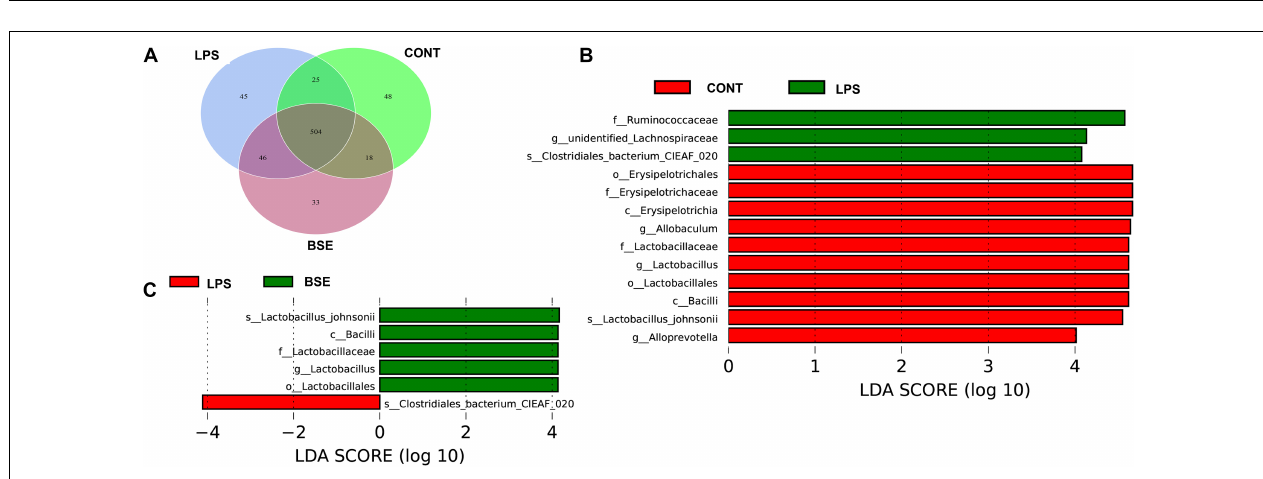
FIGURE 7 | Effects of Blidingia sp. extract on microbial community composition in cecum of lipopolysaccharide – challenged mice. (A) Venn diagram of OTUs; (B,C) Taxa value meeting a significant LDA threshold value of > 4.0 are shown, which are displayed with a positive LDA score. CONT, mice gavaged with